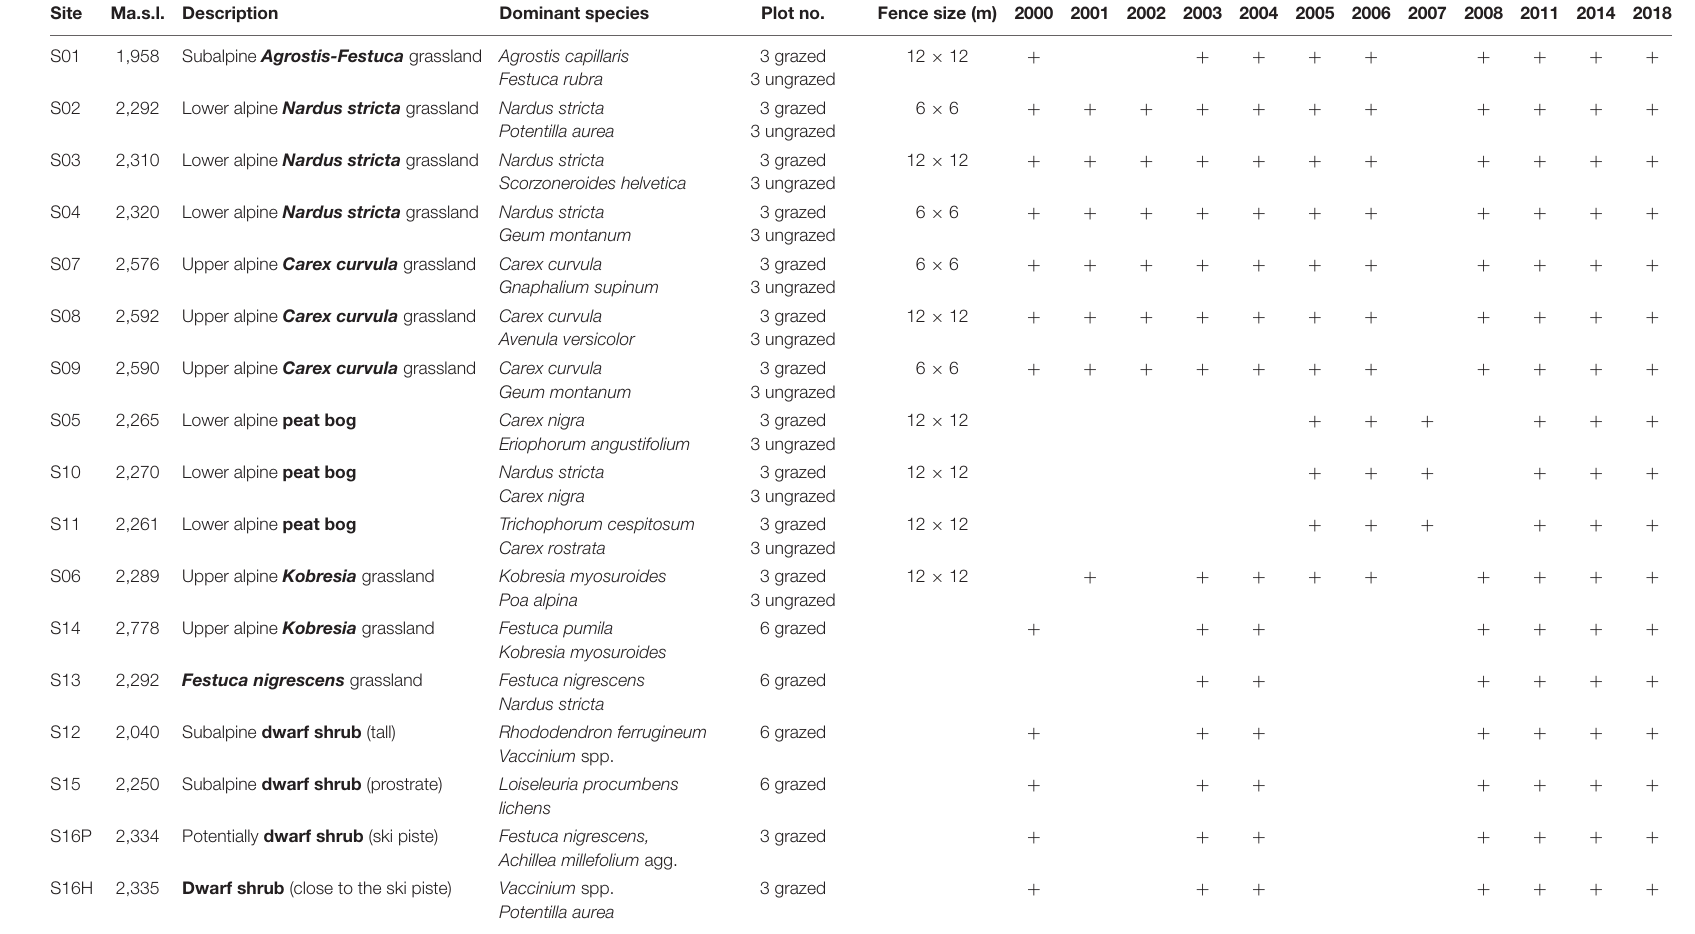
TABLE 1 | Overview on the sites and their elevation (m above sea level, a.s.l.), description of the plant communities and the dominant species, number of grazed and ungrazed plots per community, size of the fence in m, and sampling years. Site Plot